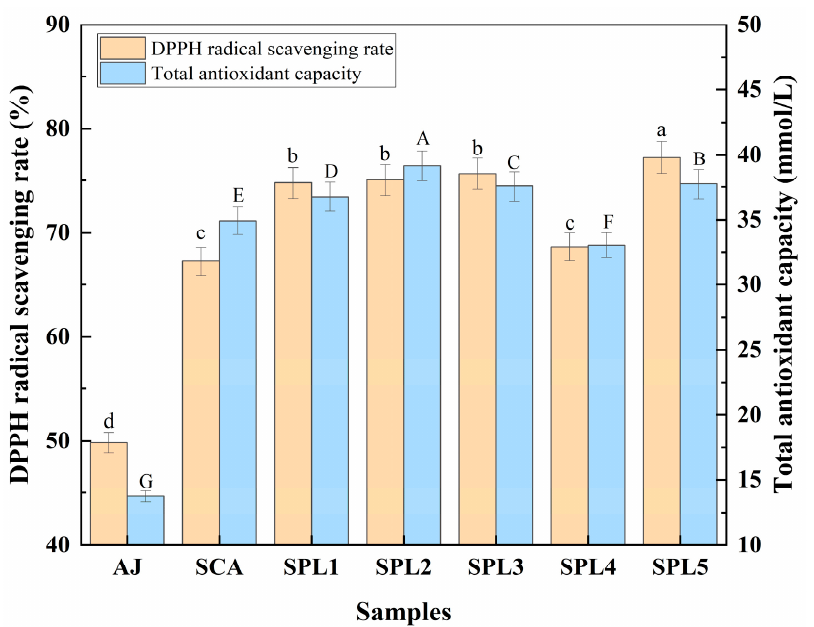
Figure 1. Changes in 1,1-diphenyl-2-picrylhydrazyl (DPPH) radical scavenging rate and total antioxidant activity of apple ciders after mono- and co-fermentation. Data with different letters (a, b, c, d) in DPPH radical scavenging rate and (A, B, C, D, E, F, G) in total antioxidant activity are significantly different ( p < 0.05), respectively.